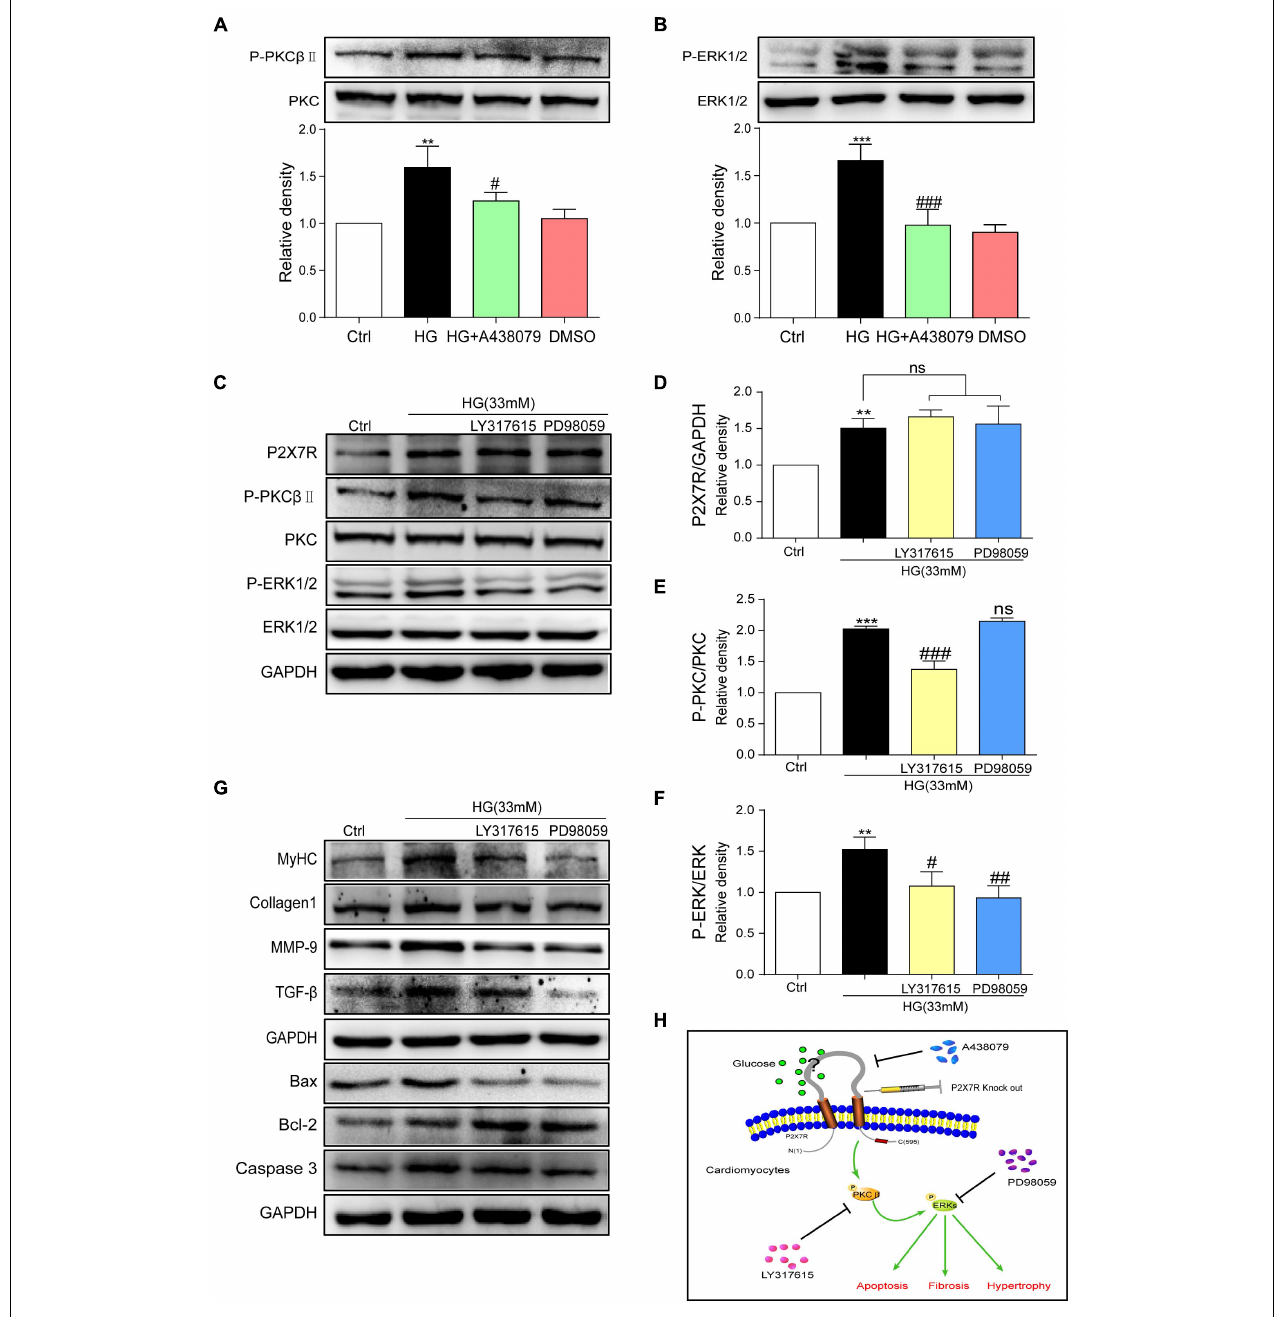
FIGURE 6 | P2X7R regulated the activation of the PKC β /ERK pathway in high glucose-induced cardiomyocytes. Total protein was extracted and p-PKC/PKC and p-ERK/ERK levels were analyzed using western blot analyses (A,B) . Levels of the P2X7R, p-PKC/PKC and p-ERK/ERK proteins were analyzed using western blotting (C) , and the quantitative statistics are presented in graphs (D–F) . The levels of pro-fibrotic, pro-apoptotic, and pro-hypertrophic proteins were determined using western blot analyses (G) . A schematic illustrating the role of P2X7R in diabetes/HG-induced injury in cardiomyocytes, the preventative effect of A438079 and the role of P2X7R knockout. (H) (Data from three independent experiments were analyzed: * p < 0.05, ** p < 0.01, and *** p < 0.001 compared with the Ctrl; # p < 0.05, ## p < 0.01, and ### p < 0.001 compared with HG